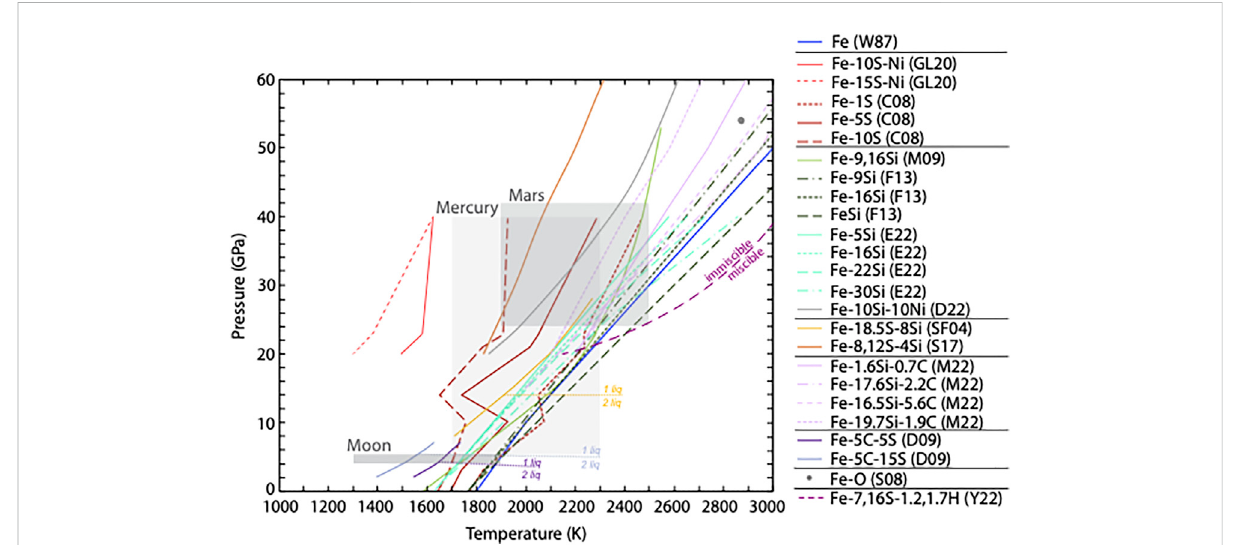
FIGURE 1 A compilation of melting curves of iron and iron alloys from experimental studies. Compositions in the legend indicate the wt% of light elements. Horizontal dotted lines correspond to immiscibility fi elds (1 liquid vs 2 liquids) in the molten state. Shaded areas indicate the present-day pressure and temperature conditions of the core of Mars, the Moon, and Mercury. Details of the melting data may be found in the following references: W87, Williams et al., 1987; GL20, Gilfoy and Li, 2020; C08, Chen et al., 2008; M09, Miller and thesis, 2009; F13, Fischer et al., 2013; E22, Edmund et al., 2022; D22, Dobrosavljevic et al., 2022; SF04, Sanloup and Fei, 2004; S17, Sakairi et al., 2017; M22: Miozzi et al., 2022; D09: Dasgupta et al., 2009; S08, Seagle et al., 2008; Y22, Yokoo et al.,